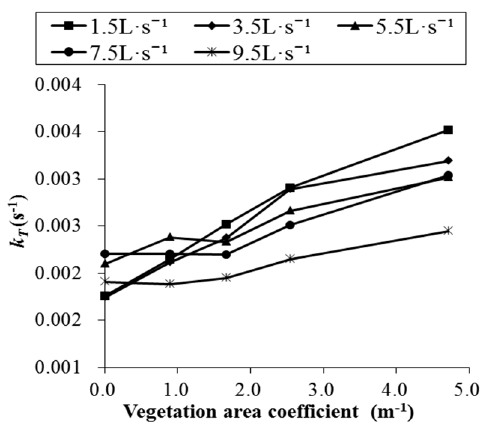
Figure 7. The relationship between k T and the vegetation area coefficient.